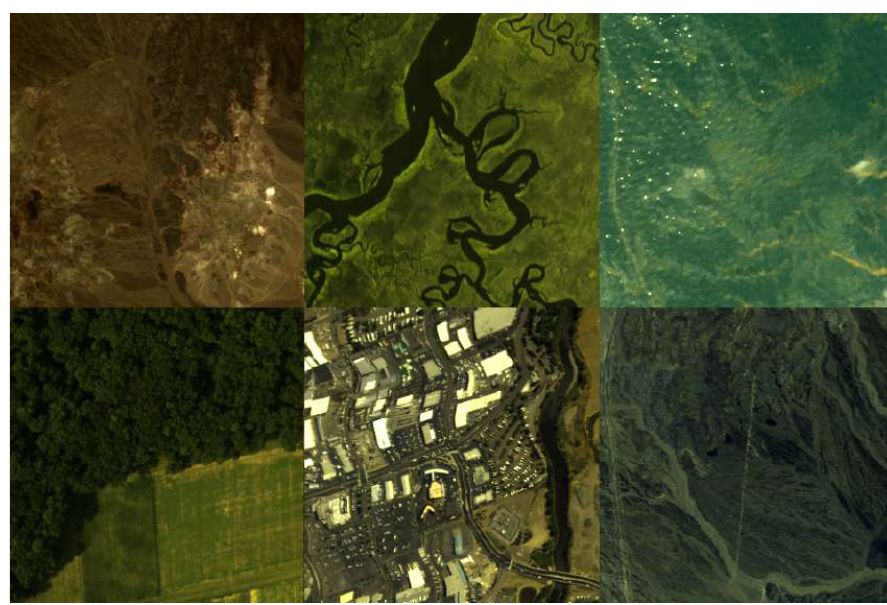
Figure 13. Small cutouts of the images from Table 3. In reading order: CUP, SUW, DHO, BEL, REN, CRW.